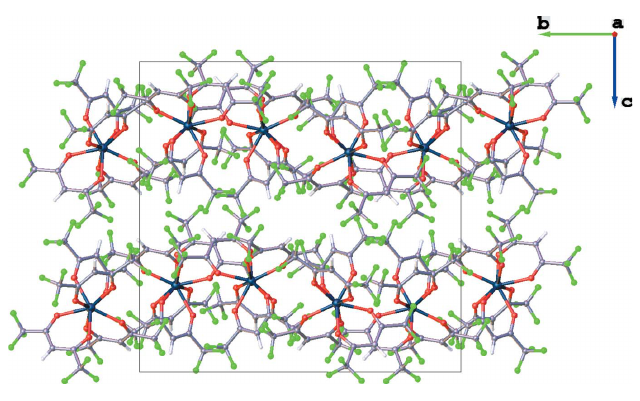
Figure 4 The layered structure of Hf(hfac) 4 as viewed along the a axis.